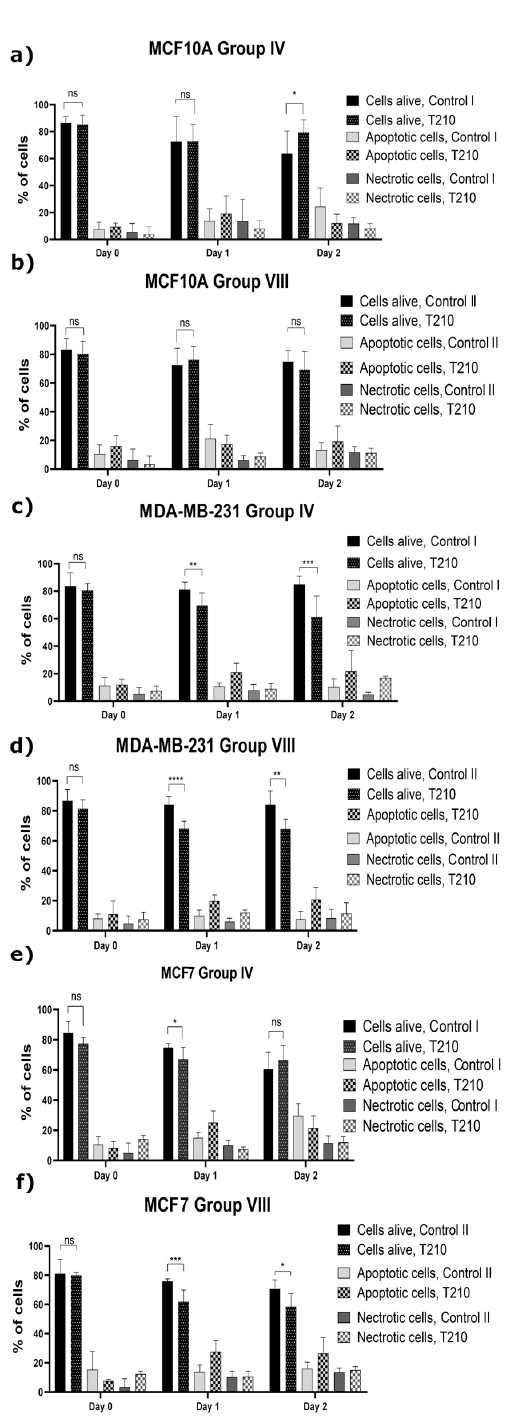
Figure 4. The results on the population of the alive, apoptotic, and necrotic cells of the human breast cell line MCF10A ( a , b ) and the human cancer cell lines, i.e., MDA-MB-231 ( c , d ), and MCF7 ( e , f ). The MCF10A ( a ), MDA-MB-231 ( c ), and MCF7 ( e ) cell lines cultured for 2 days in 1.5 mL of the CAPP-activated DMEM for 210 s (Group IV), as well as 1.5 mL of the CAPP-activated Opti- MEM for 210 s (Group VIII): MCF10A ( b ), MDA-MB-231 ( d ), MCF7 ( f ). The calculated results presented as means ± SD values for three independent experiments performed in duplicates. The statistical calculation was performed by comparison of all investigated groups versus the control using the one-way ANOVA with the Dunnett’s post hoc test (* p < 0.015, ** p < 0.0015, *** p < 0.0004, **** p < 0.0001, n.s. not significant).